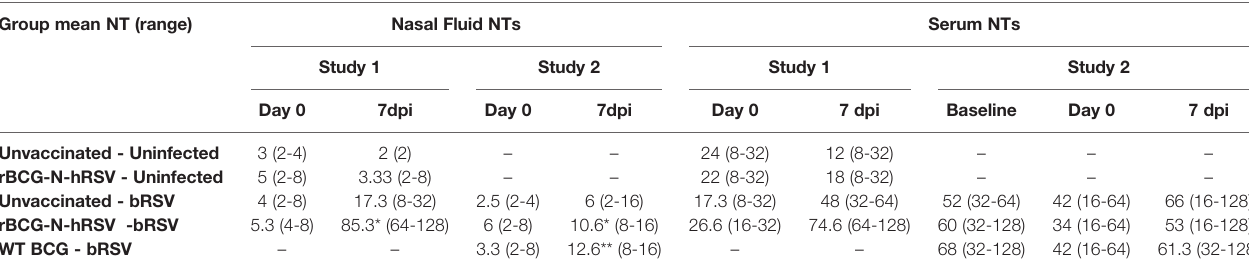
TABLE 2 | Virus neutralization